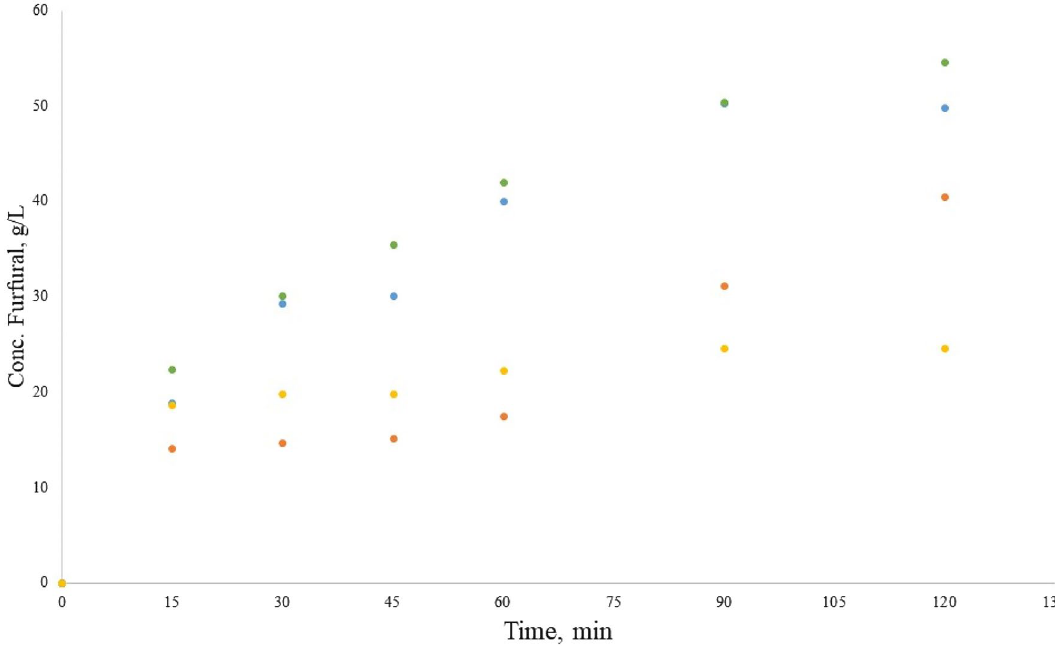
Figure 3. Furfural production in the hydrolysis reaction with Ca(OH) 2 , from orange pectin (blue circle), tangerine pectin (green circle), mango pectin (orange circle) and tamarind pectin (light orange circle).